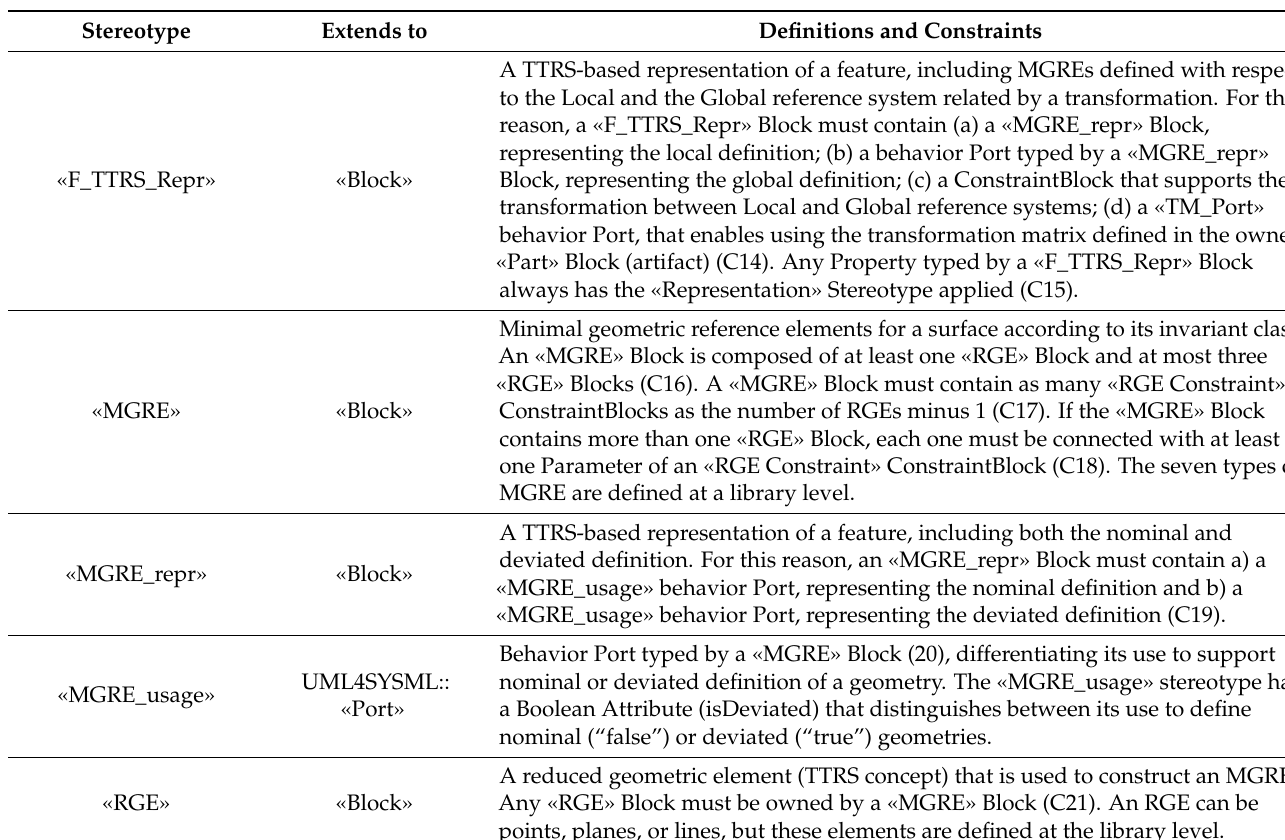
Table A3. Description of main TTRS_MPP